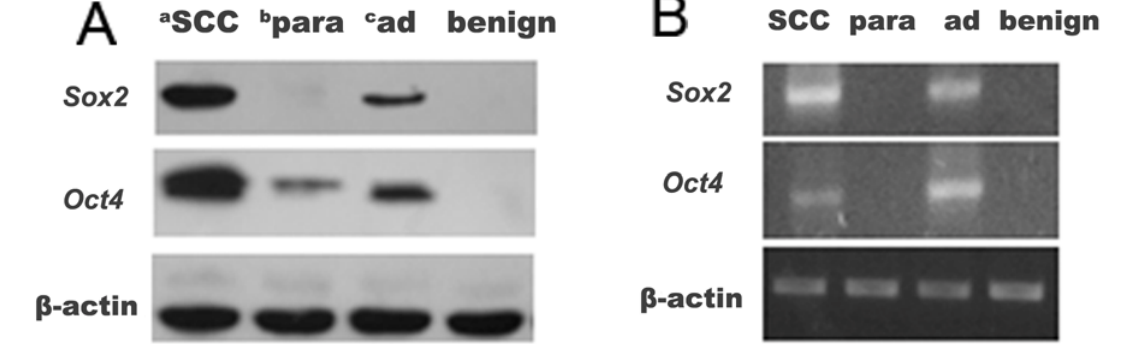
Figure 2. Western blot and reverse transcription polymerase chain reaction (RT-PCR) analysis on the expression of Sox2 and Oct4 in lung SCC, adenocarcinoma, paracancerous and benign tumor tissues; ( A ) Western blot; ( B ) RT-PCR. a SCC = squamous cell